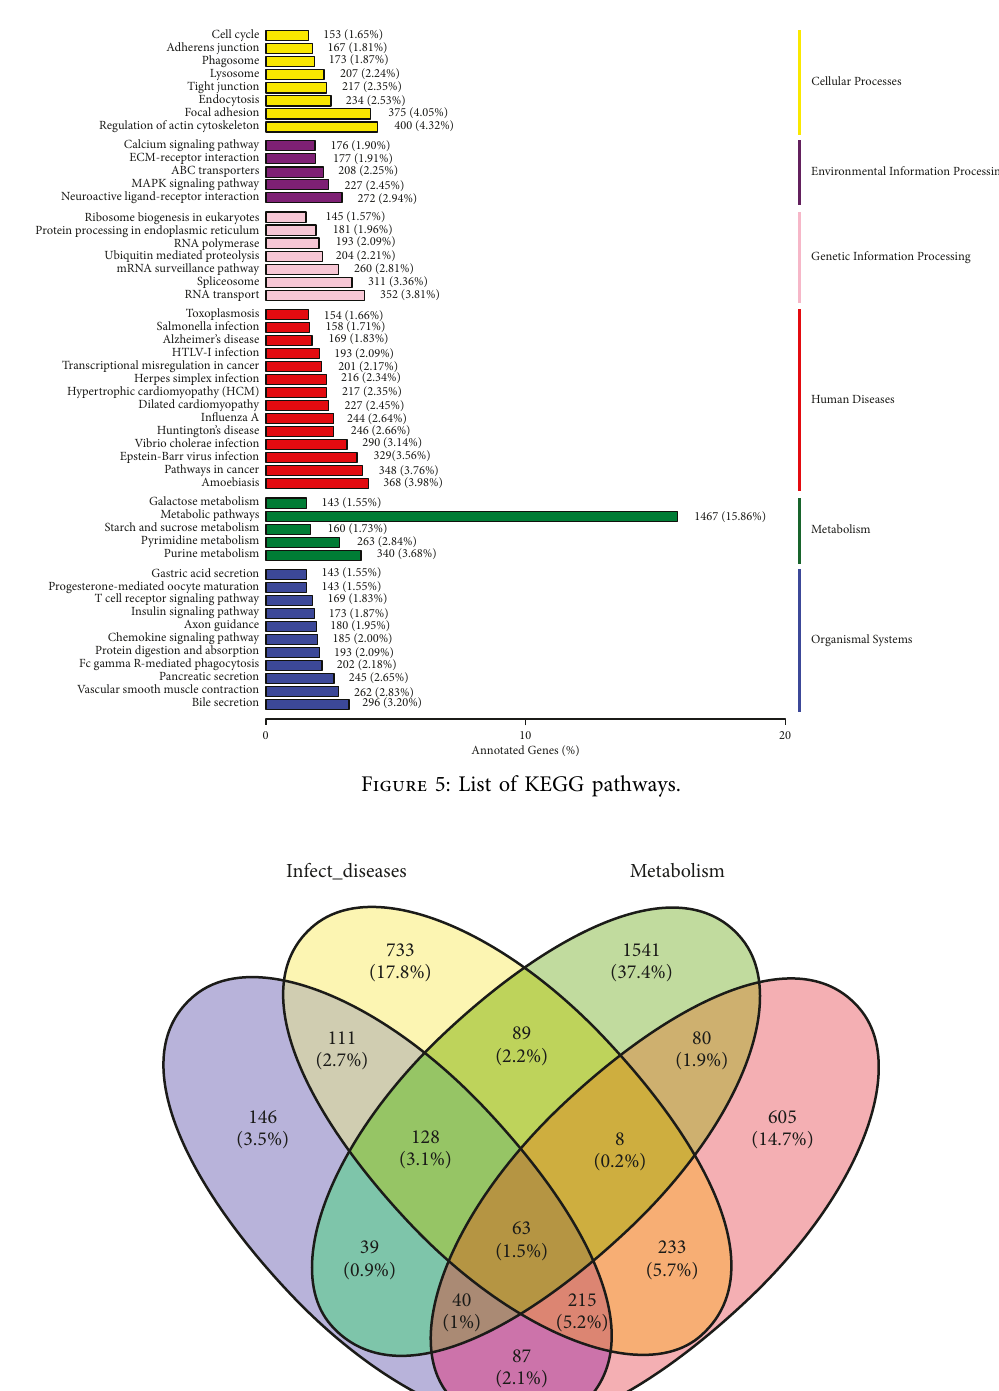
Figure 6: A Venn diagram depicting the results of KEGG pathway analysis.